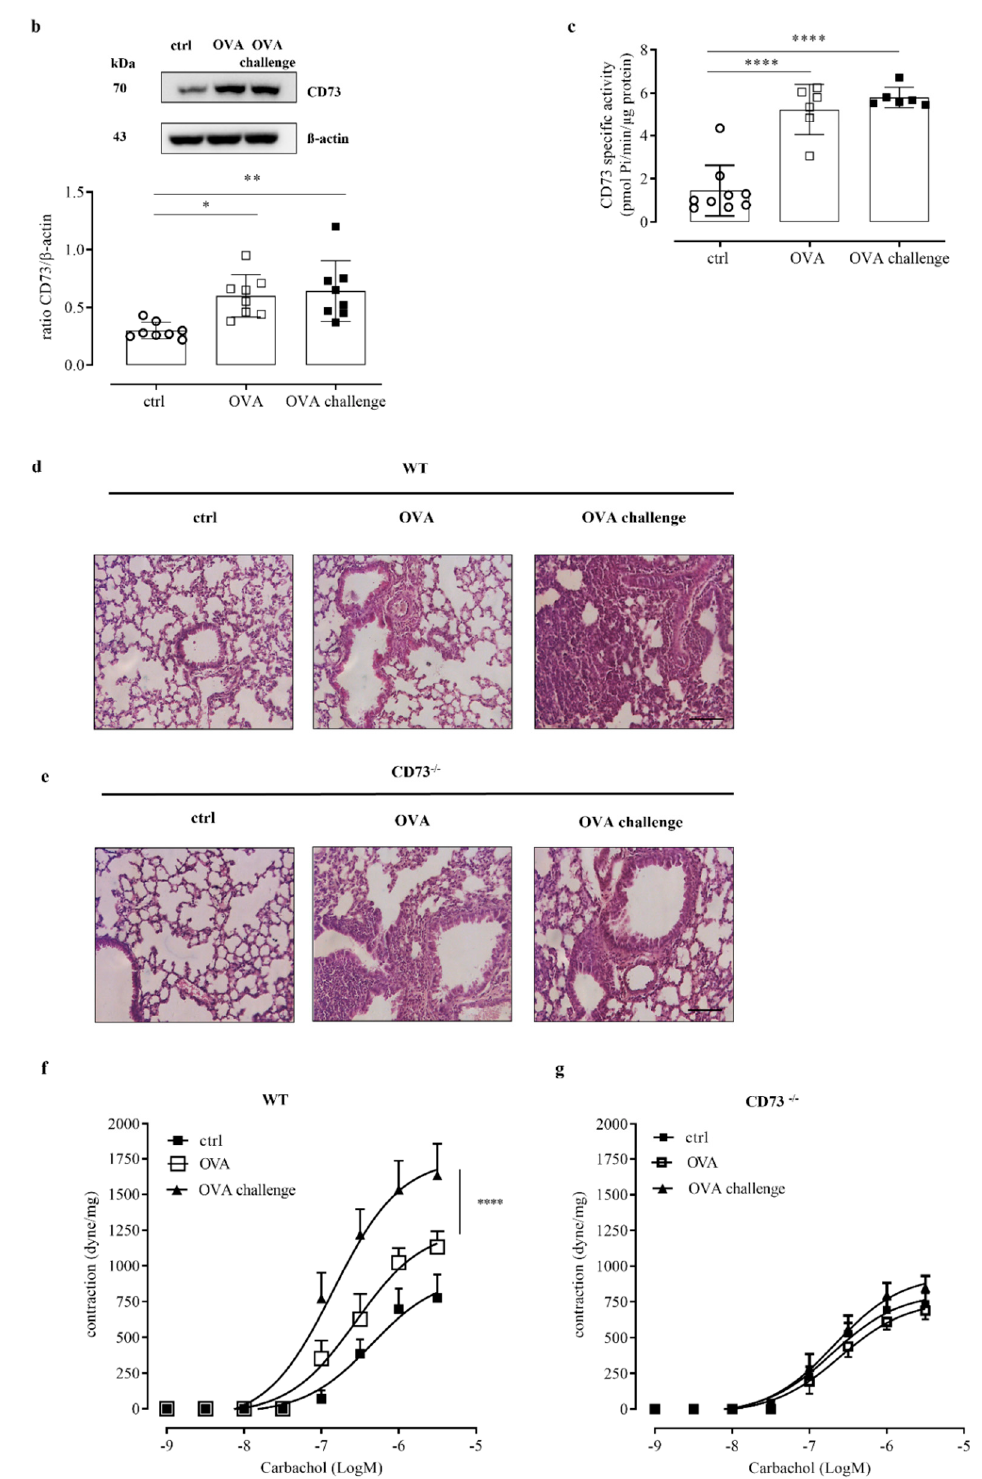
Figure 1. ( a ) OVA sensitization and aerosol challenge protocol in WT and CD73 − / − mice. Mice were sensitized and challenged with OVA as described in Materials and Methods. ( b ) CD73 pulmonary expression in control and OVA-sensitized and challenged WT mice was evaluated by Western blots. Data are expressed as means ± SE of eight mice per group. * p < 0.05 and ** p < 0.01 (one-way ANOVA followed by Bonferroni’s Multiple Comparison Test). ( c ) AMPase activity was determined by Malachite Green assay in lung tissue from control and OVA-sensitized and challenged WT mice. All data are expressed as mean ± SE of six to nine mice per group. **** p < 0.0001 (one-way ANOVA followed